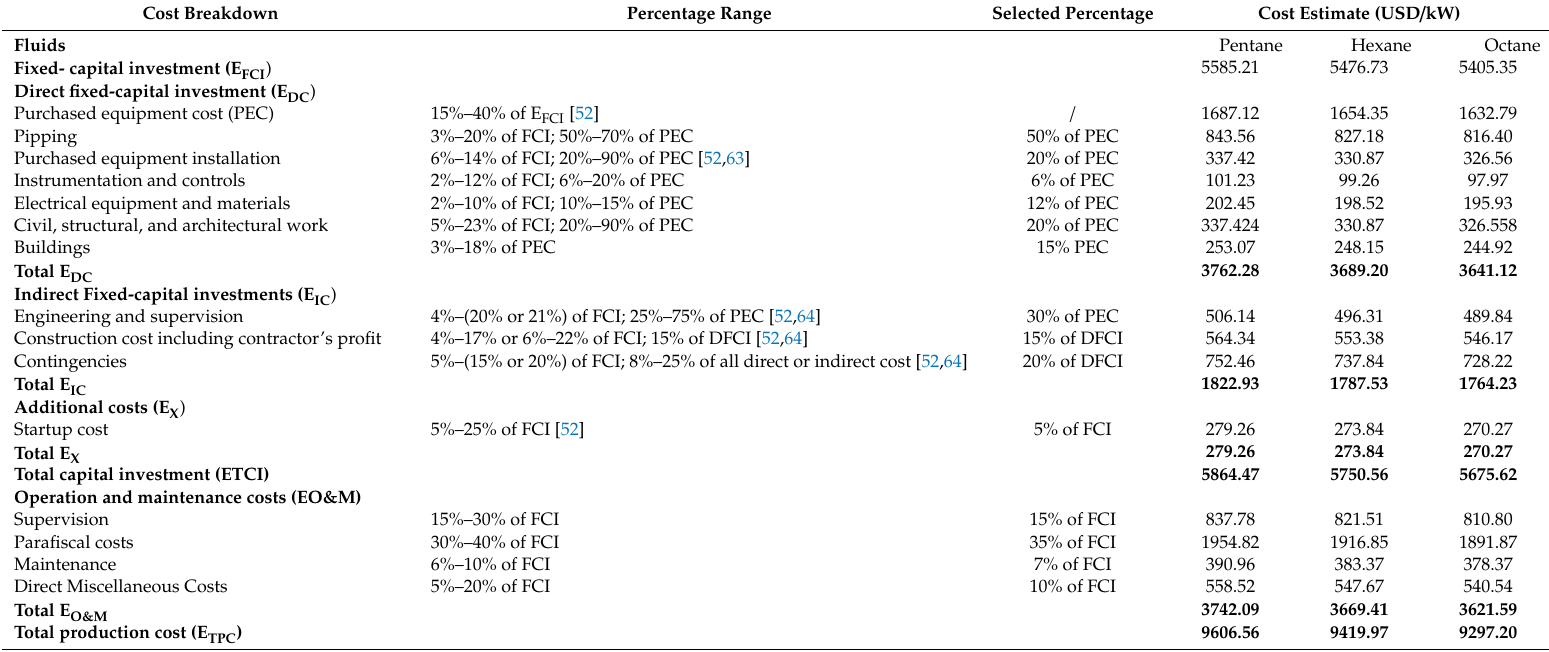
Table 9. Total production costs estimation for di ff erent working